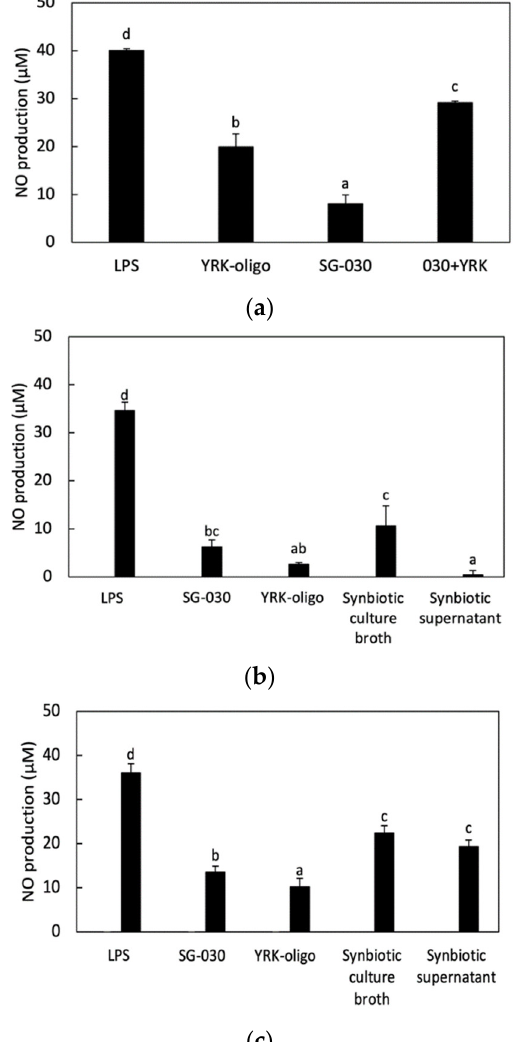
Figure 3. Effects of synbiotics on nitric oxide production in RAW 264.7 cells. ( a ) RAW 264.7 cells were treated with L. lactis SG-030 alone, oligosaccharides alone, or synbiotics in the combination of L. lactis SG-030 and glucooligosaccharides; ( b ) RAW 264.7 cells were treated with L. lactis SG-030 alone, 0.1 μg/mL oligosaccharides alone, synbiotic culture broth, or the supernatant of synbiotics culture; ( c ) RAW 264.7 cells were treated with L. lactis SG-030 alone, 0.5 μg/mL oligosaccharides alone, synbiotic culture broth, or the supernatant of synbiotics culture, Different letters show significant differences among groups at p < 0.05 (n ≥ 3). LPS, lipopolysaccharides; SG-030, L. lactis SG-030; YRK-oligo, 0.1 μg/mL or 0.5 μg/mL of oligosaccharides from W. cibaria YRK005; 030 + YRK, combination of L. lactis SG-030 and oligosaccharides from W. cibaria YRK005. When RAW 264.7 cells were treated with L. lactis SG-030 alone, 0.1 µ g/mL